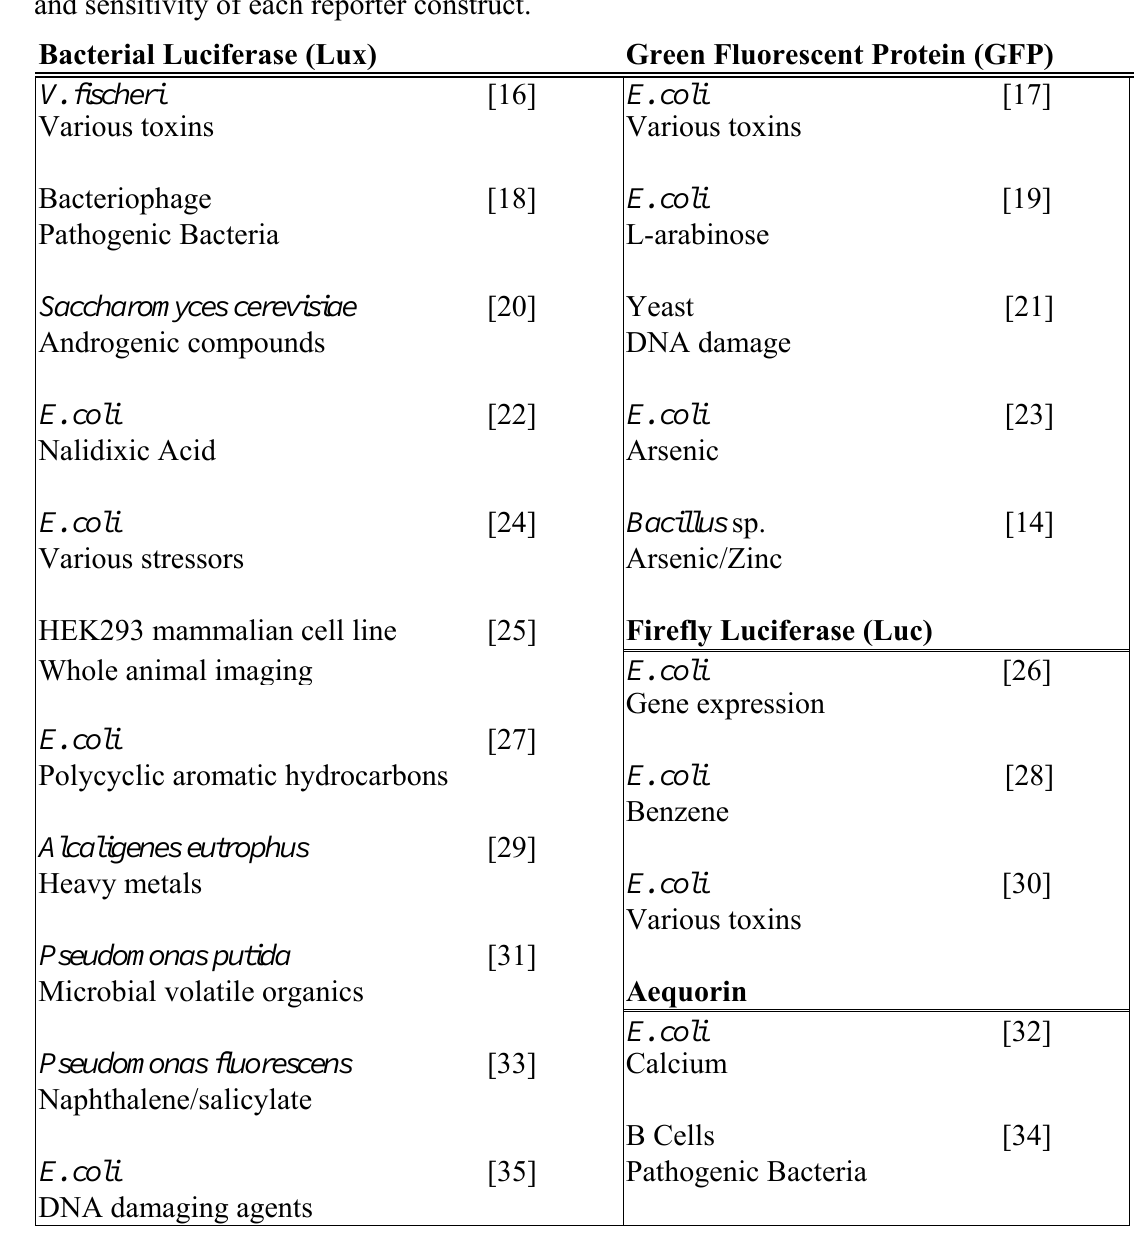
Table 1. Whole-cell bioreporters referenced in the text. Reporters are grouped by the bioluminescent or fluorescent system exploited. Reporter cell type is listed above the compound(s) detected and references refer to original publications detailing construction and sensitivity of each reporter